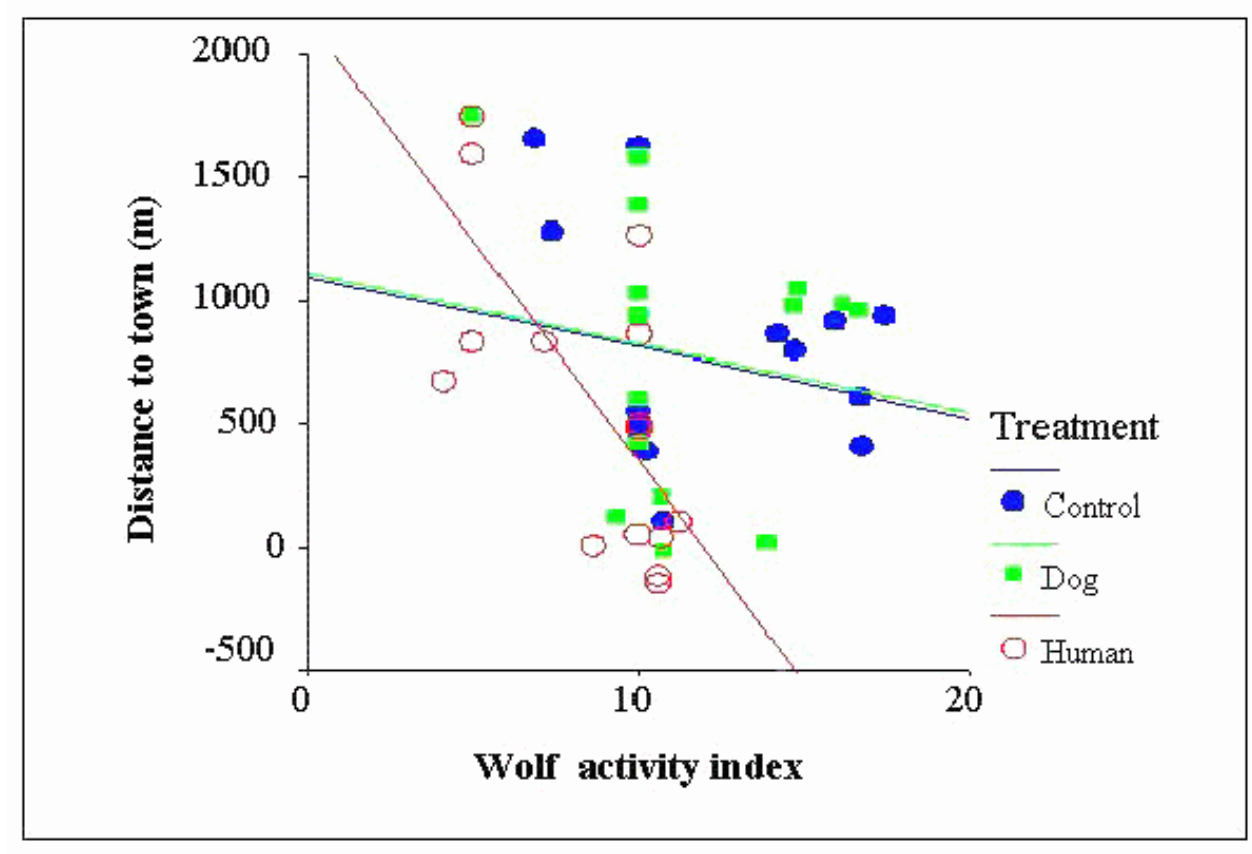
Fig. 6. Relationship between the proximity of elk to the town boundary and nearby wolf activity for elk that were subjected to human (red-rimmed circle), dog (green square), and control (blue circle) aversive conditioning treatments in Banff National